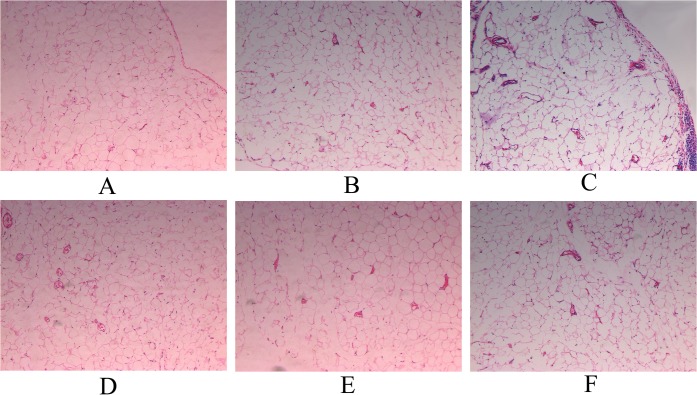
Numbers of neovessels in greater omentum under microscope (HE staining, ×100).Group CON (A), group NS (B), group GLU (C), group HEP (D), group LLMWH (E) and group HLMWH (F).